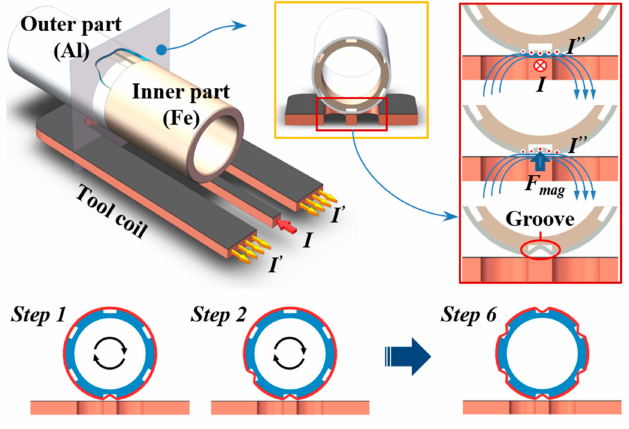
Figure 1. Schematic of electromagnetic crimping using a flat coil.